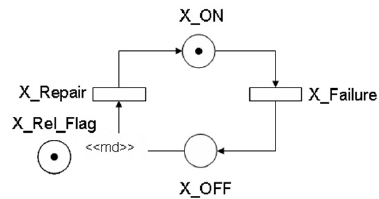
Figure 4. Simple component